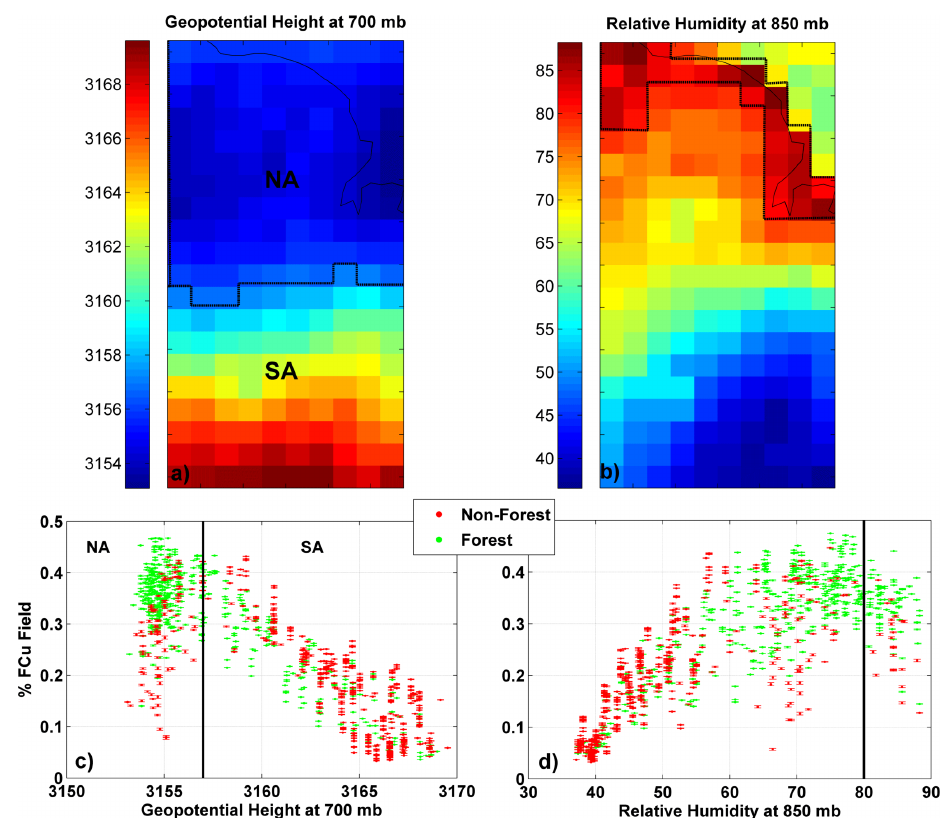
Figure 5. Meteorological setting (based on GDAS analysis data) in the Amazon during J-A-S and the effects on pFCu over forest and non-forest land covers. (a) geopotential height (HGT) [m] at 700hPa pressure level; the dashed line represents the border between NA and SA regions. (b) Relative humidity (RH) [%] at 850hPa; high-RH areas enclosed within the dashed line are excluded from further analyses. (c) Chance of observing FCu field as a function of HGT at 700hPa. Data are sorted into 500 bins, with 11484 and 2808 counts per bin for forest and non-forest, respectively. The black line represents HGT separation between NA and SA regions. (d) Same as (c) , but for RH at 850hPa. Data above RH = 80% (black line in panel) are excluded from analyses in this work.